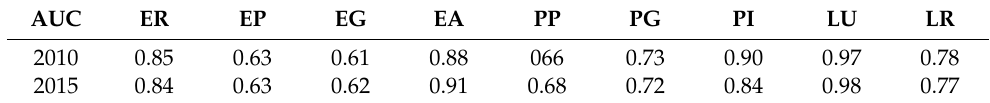
Table 5. AUC values based on ANN suitability probability calculation results.